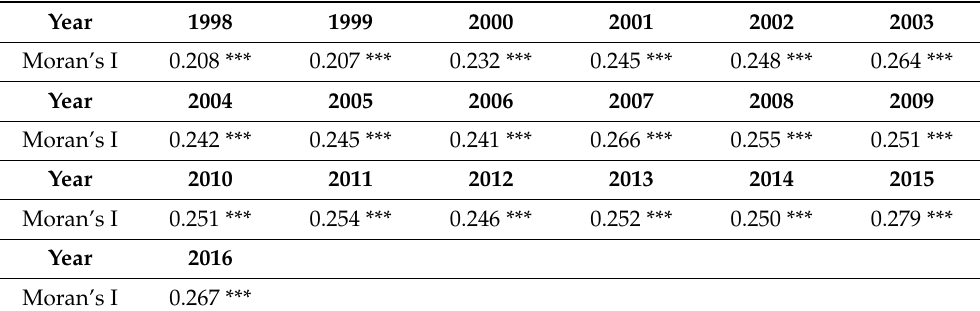
Table 1. Global spatial correlation of PM 2.5 concentrations.